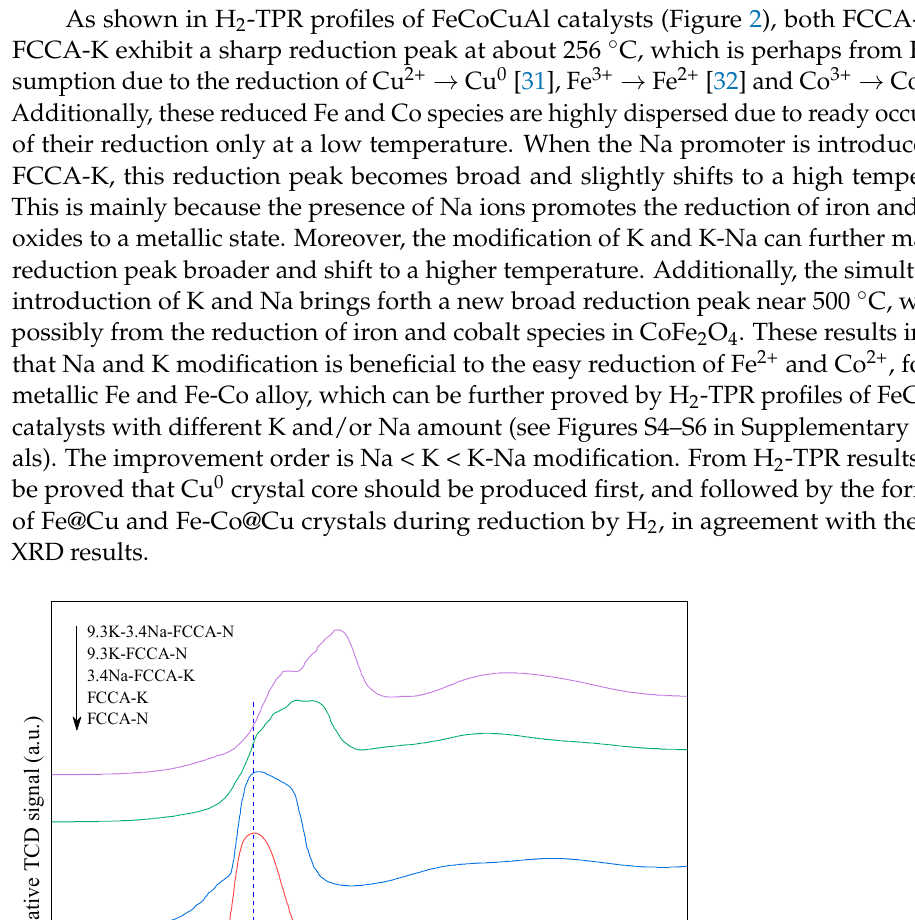
4 of 11 Figure 1. XRD pattern of reduced FeCoCuAl catalysts before and after K and/or Na modification. Catalyst reduction at 400 °C for 1 h in pure H 2 . 2.2. H